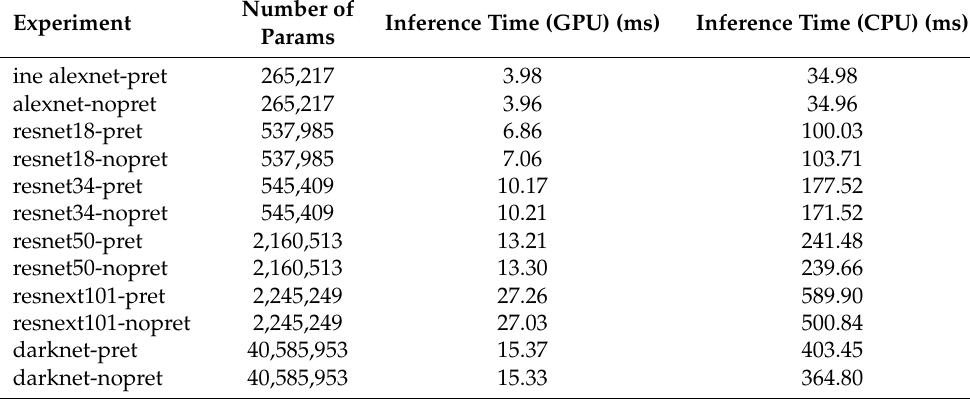
Table 6. Efficiency